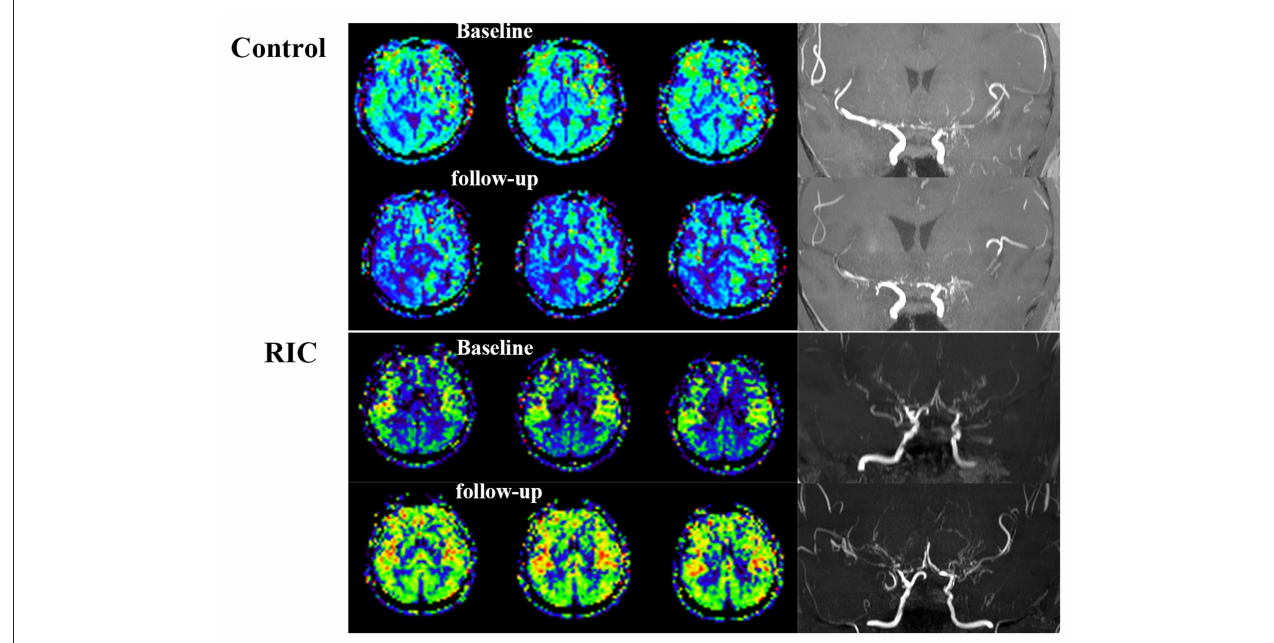
FIGURE 3 | Cerebral blood flow and stenotic-occlusive lesion at baseline and follow-up. ASL images of the patient in the control group showed deterioration of CBF mainly at the right side, which could be reflected by the progression of stenotic-occlusive lesion at right middle cerebral artery (MCA). arterial spin labeling (ASL) images of the remote ischemic conditioning (RIC) group demonstrated improved CBF and more abundant collaterals after RIC treatment in both the sides.